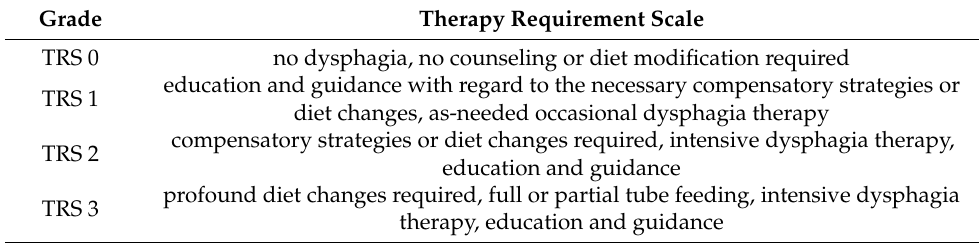
Table 1. Therapy Requirement